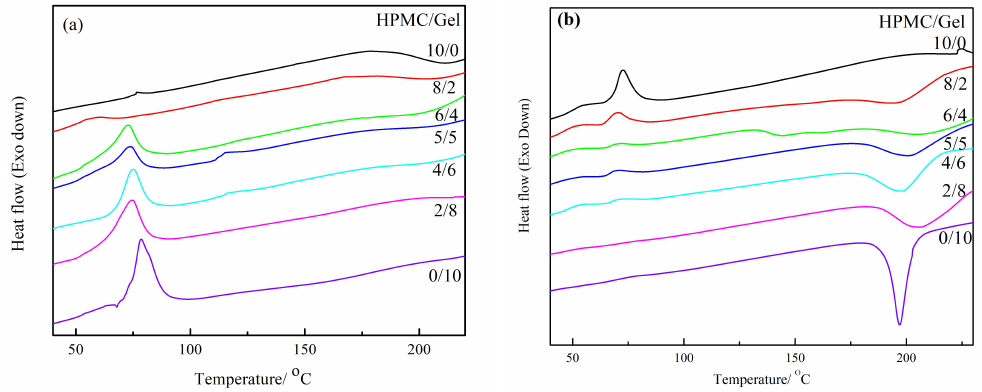
Figure 1. The DSC curves of all samples: ( a ) natural dry; ( b ) freeze